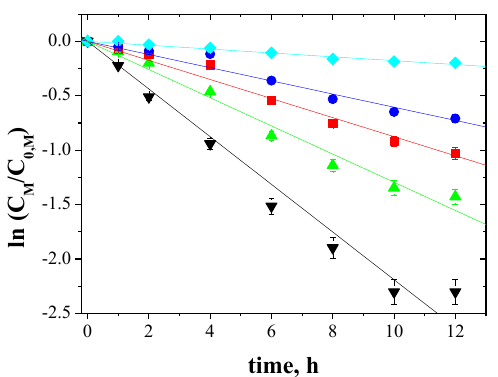
Figure 5. Kinetics of the transport across PIMs containing EDAB-acac for 5-component mixture of ▼ - Zn(II), ▲ -Cd(II), -Co(II), -Cu(II), and -Ni(II).